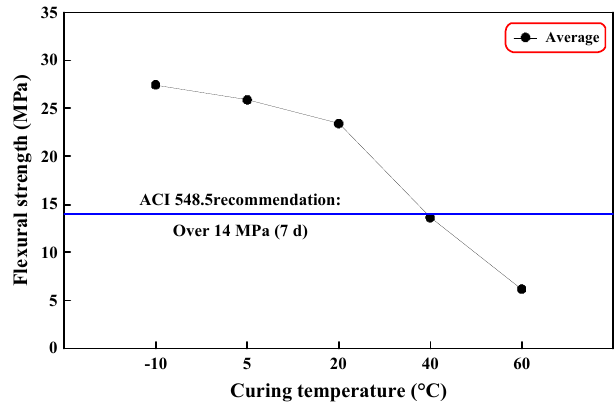
Figure 6. Effect of curing temperature on average flexural strength.